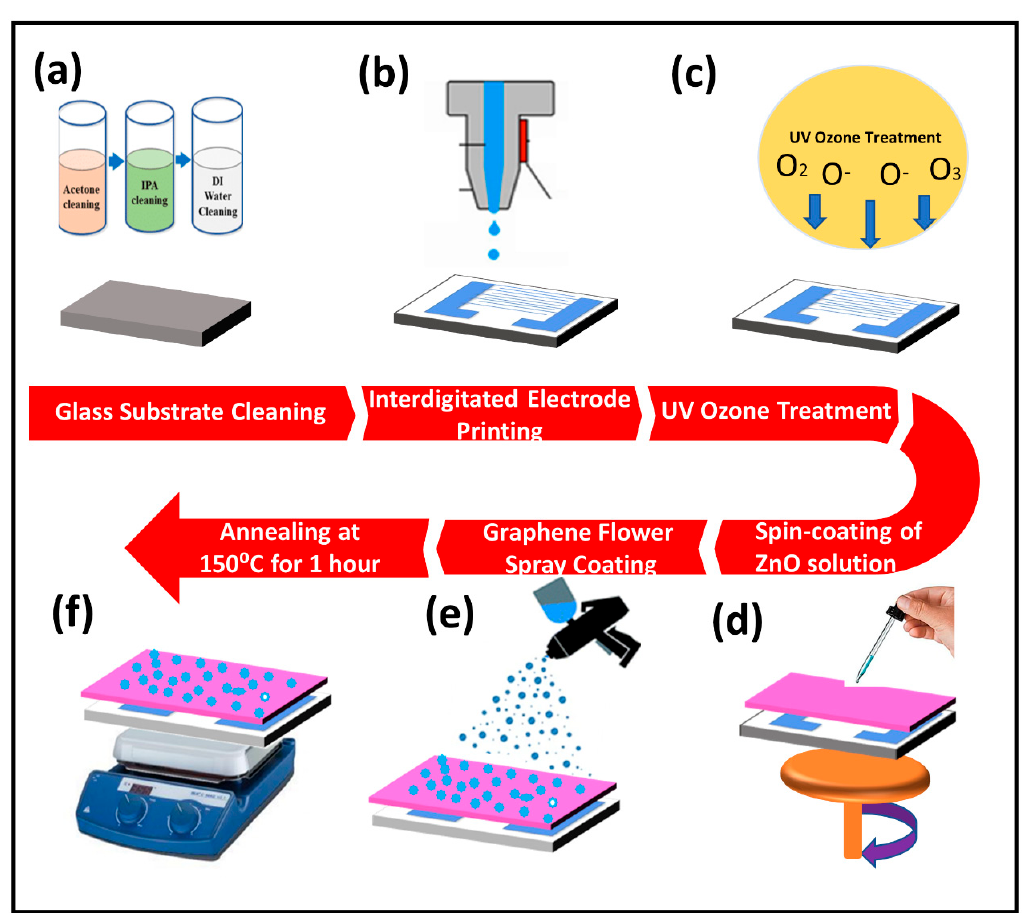
Figure 1. Process flow diagram: ( a ) substrate cleaning ( b ) electrode printing ( c ) UV-ozone treatment ( d ) sol–gel ZnO thin film deposition ( e ) graphene flower (GrF) spray coating ( f ) annealing for 1